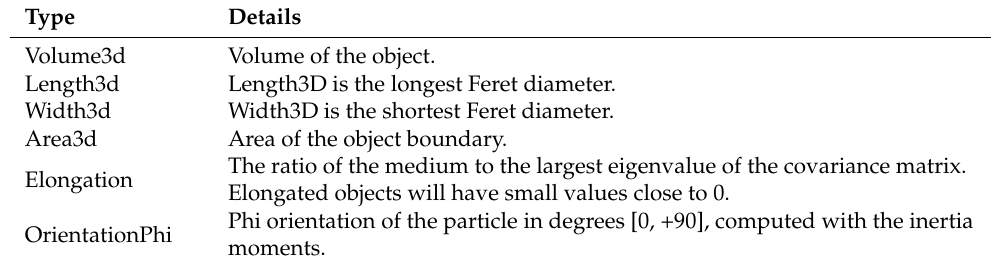
Table 4. Data types from the evaluation